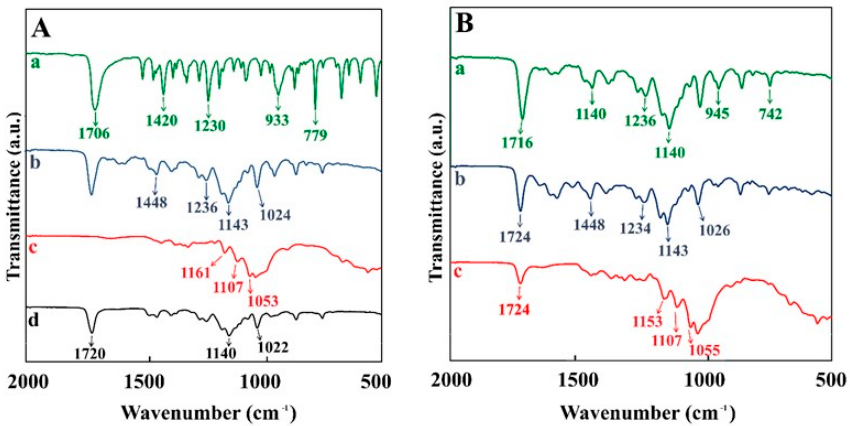
Figure 9. FTIR spectra of ( A ) pure materials: (a) ibuprofen, (b) tetracycline, (c) nanocellulose, and (d) PEMA. ( B ) composite films: (a) PEMA-ibuprofen, (b) PEMA-tetracycline and (c) PEMA-nanocel- lulose.